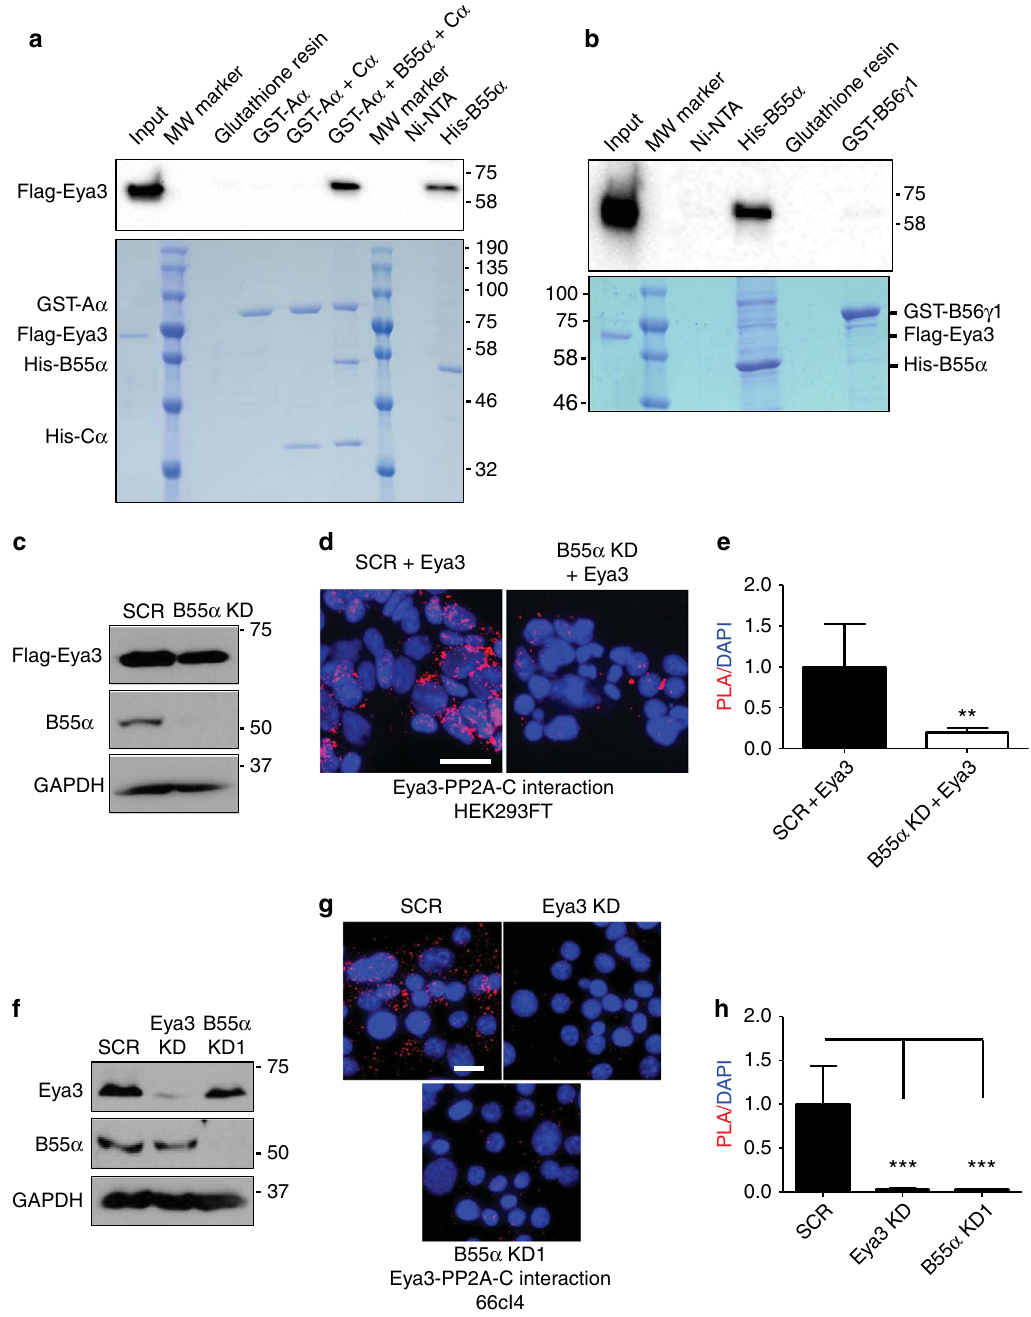
Fig. 4 Eya3 interacts directly with the PP2A-B55 α subunit. a Top: GST-A α , GST-A α + B55 α , GST-A α + B55 α + C α , or His-B55 α were used to pull down puri fi ed Flag-Eya3, which was identi fi ed using an anti-Flag antibody and western blot analysis. Bottom: Coomassie blue stained SDS PAGE gel demonstrating the amount of PP2A subunits used for pull-down experiments. b His-B55 α and GST-B56 γ 1 were used to pull down puri fi ed Flag-Eya3, which is identi fi ed using an anti-Flag antibody and western blot analysis. Bottom: Coomassie blue stained SDS-PAGE gel demonstrating the amount of PP2A subunits used for pull-down experiments. c Western blot analysis shows protein levels of Flag-Eya3 and PP2A-B55 α in SCR or PP2A-B55 α KD HEK293FT cells transfected with Flag-Eya3. Molecular weight markers in kilodalton are labeled on the side of western blots. d Representative images